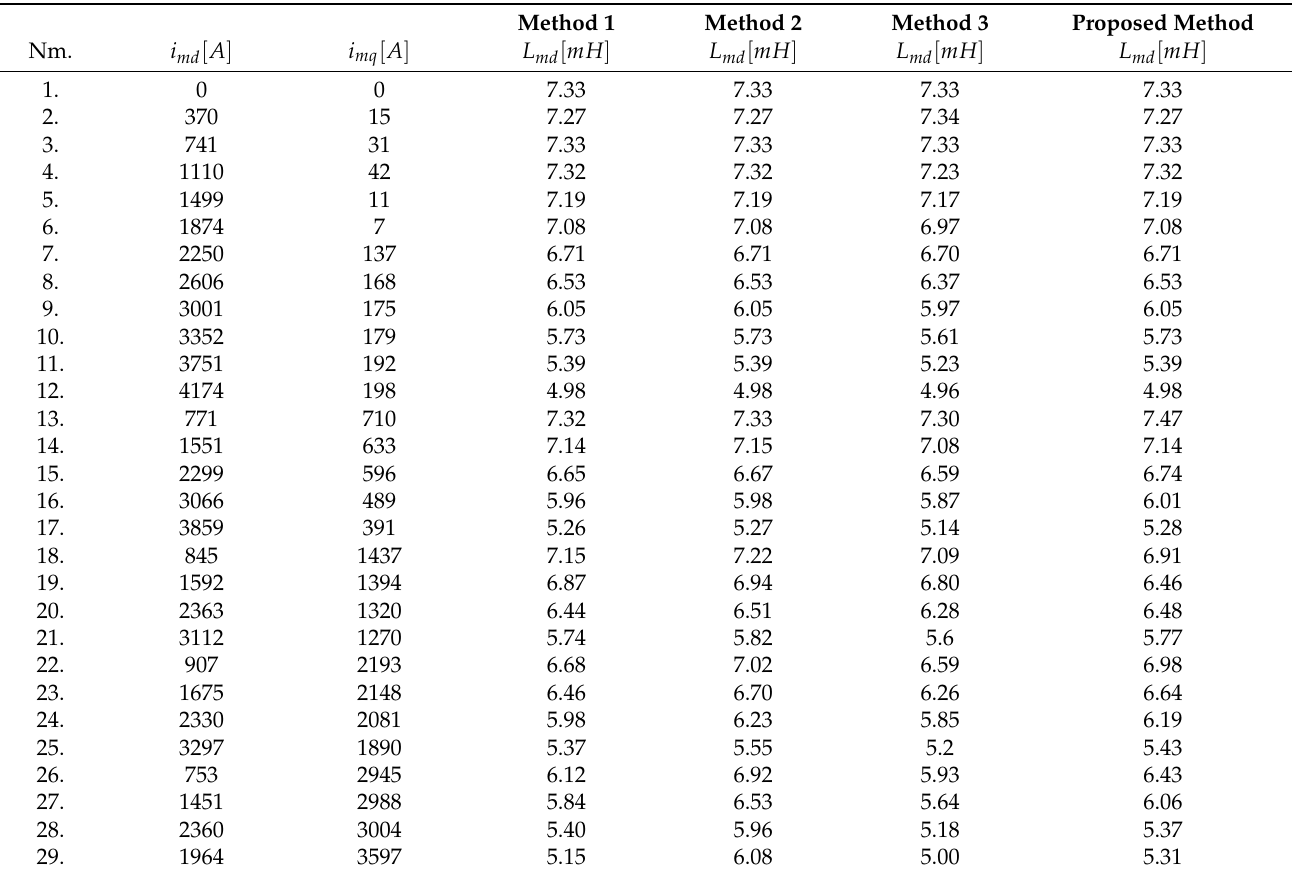
Table A1. Comparison of the obtained L md